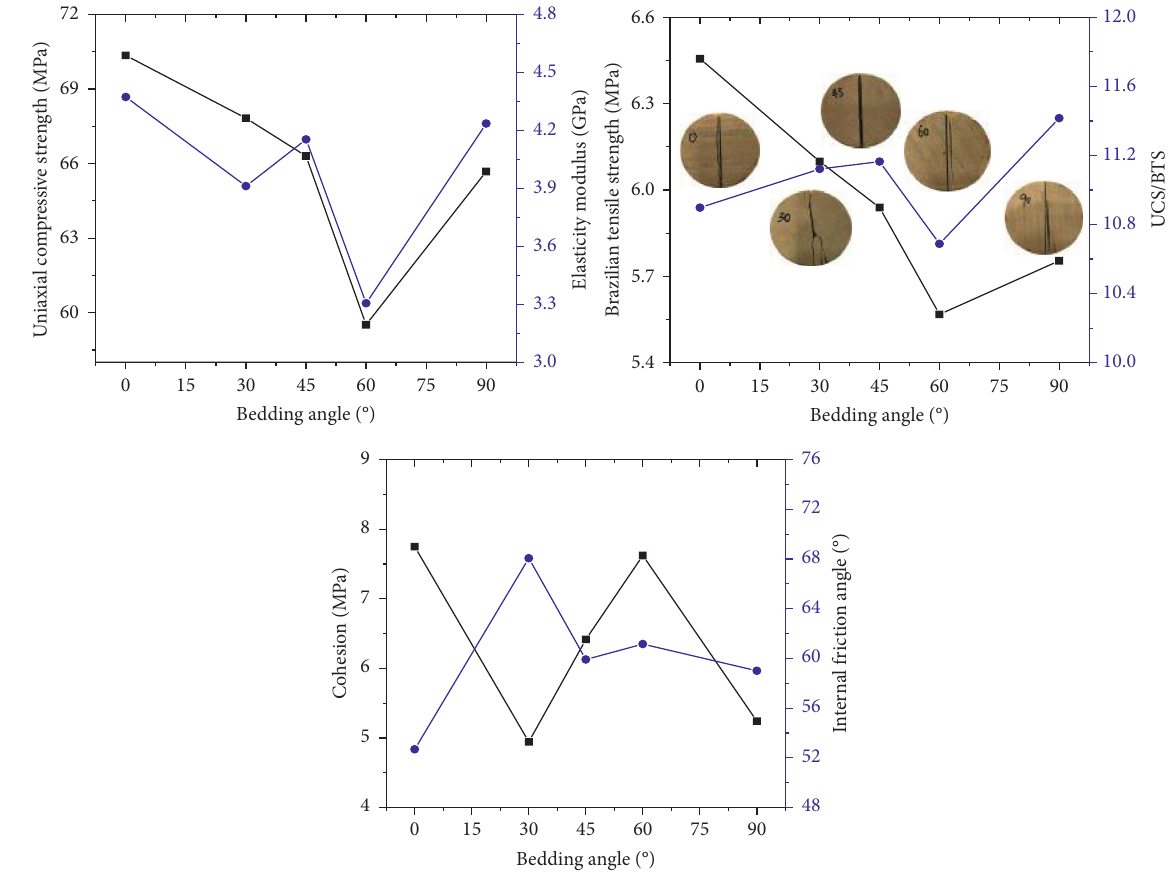
Figure 3: The variations in the main mechanical parameters with the inclination angle.